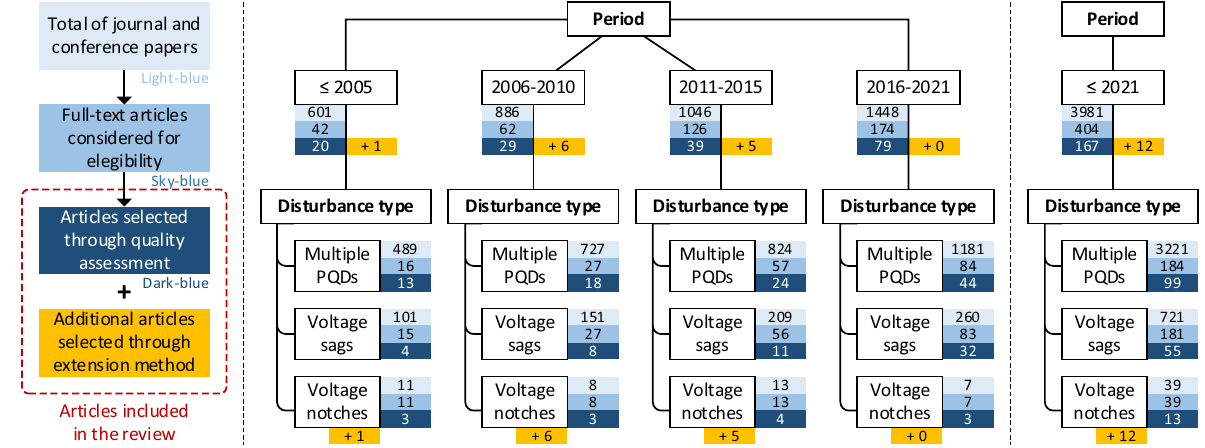
Fig. 4 Number of papers through the process of selection for the critical review, organized by period and type of PQD